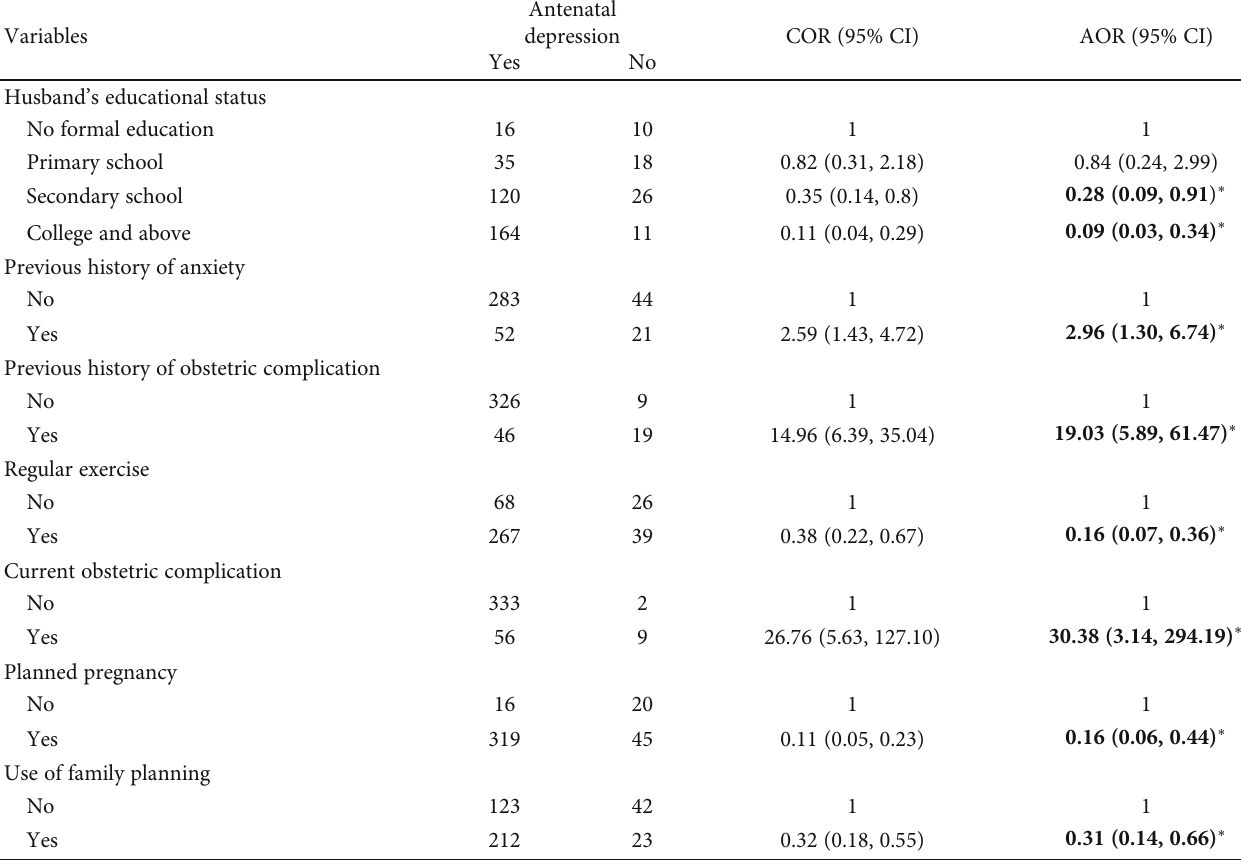
Table 3: Predictors of antenatal depression among pregnant women ( n = 400 ) attending antenatal care in Sodo town health facilities, Southern Ethiopia,